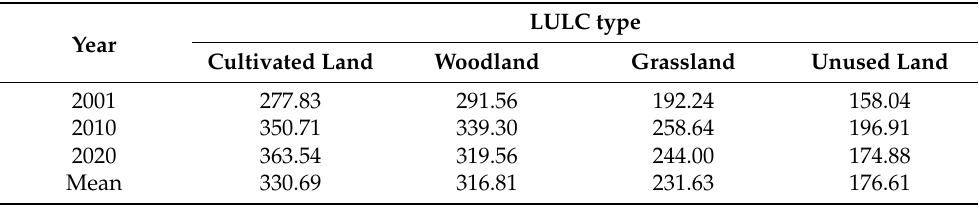
Table 2. Annual average net primary productivity (NPP) (gC · m –2 · a –1 ) by land use/land cover (LULC) types at different time periods.